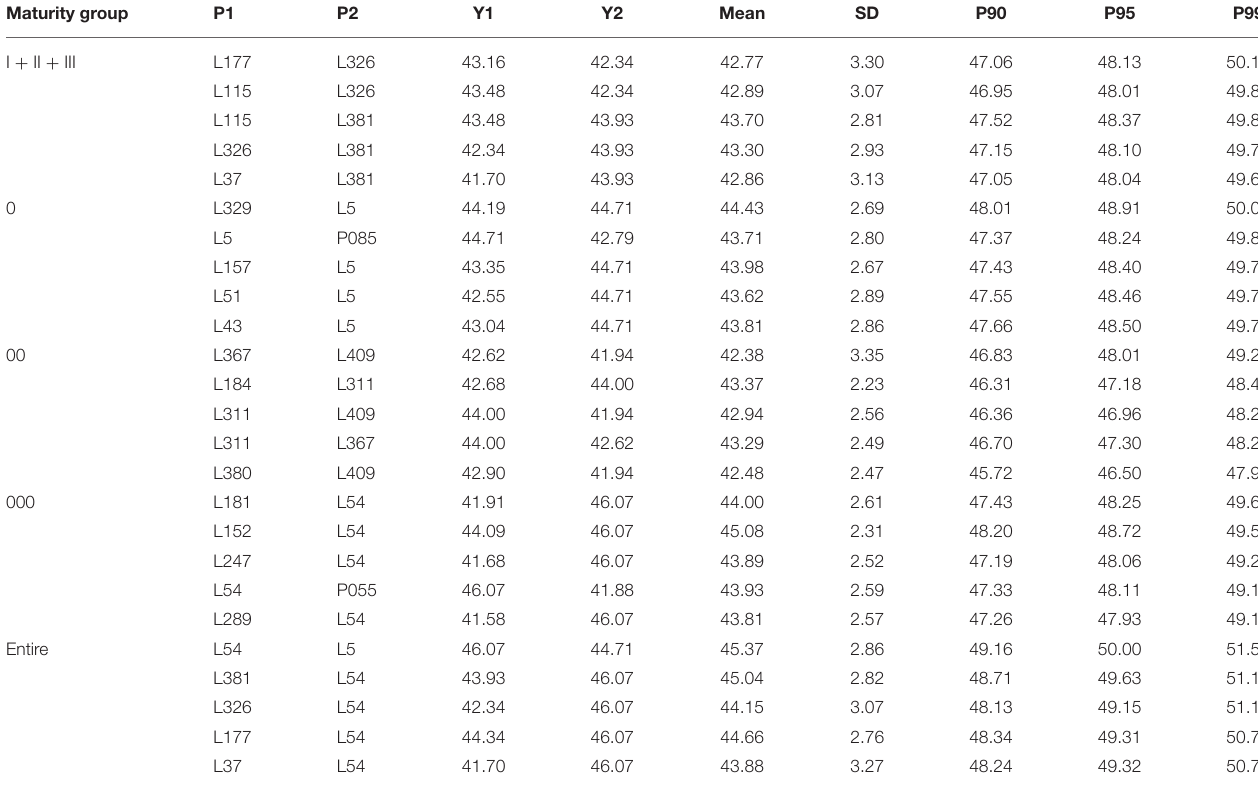
TABLE 5 | Optimal crosses for high SPC in different maturity groups (%). Maturity